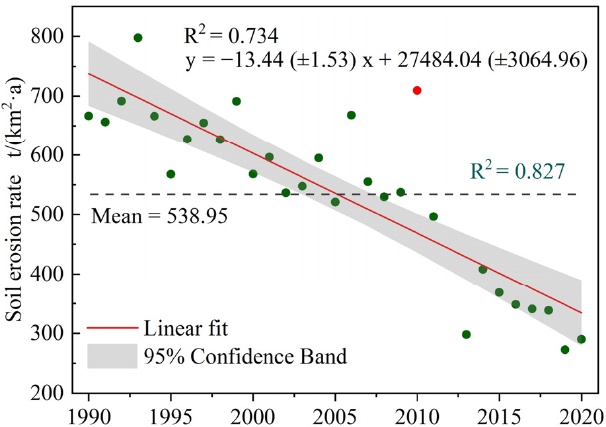
Figure 4. Scatter plot of soil erosion rate from 1990 to 2020 (except 2012). The green dots represent soil erosion rate, the red curve is a linear fit line, and the gray band is a 95% confidence band. Please note: In 2010, soil erosion could be overestimated due to the cloud effect.